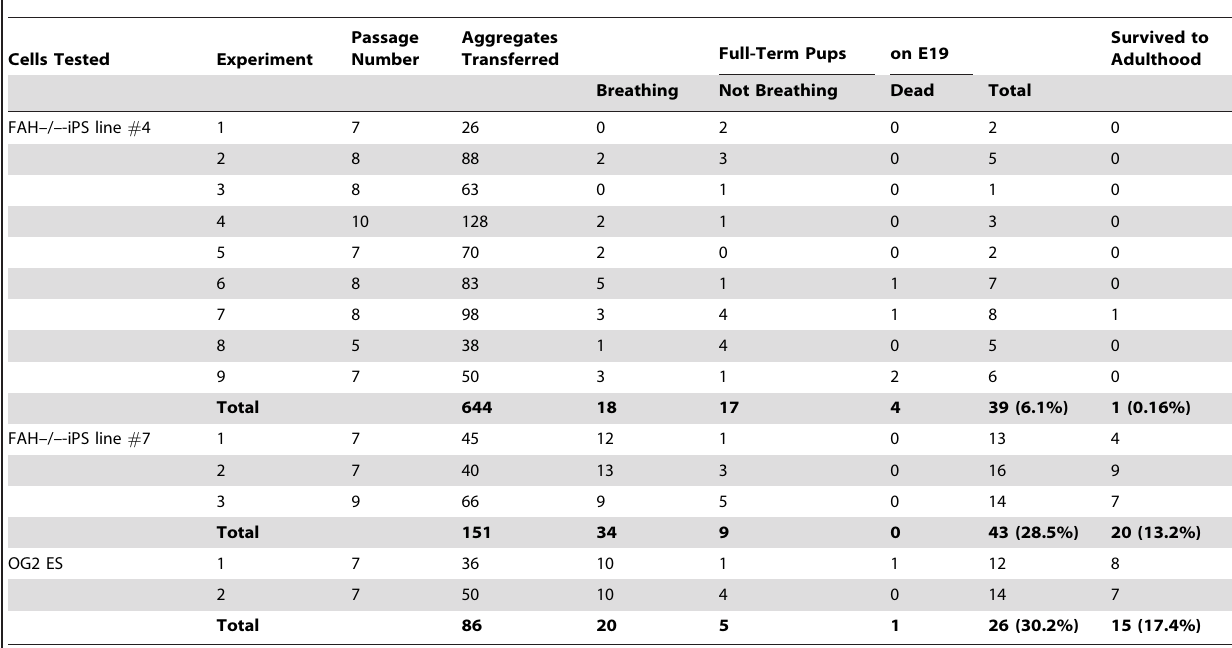
Table 1. Experimental summary of tetraploid complementation of FAH 2 / 2 -iPS cells compared with OG2 ES cells.